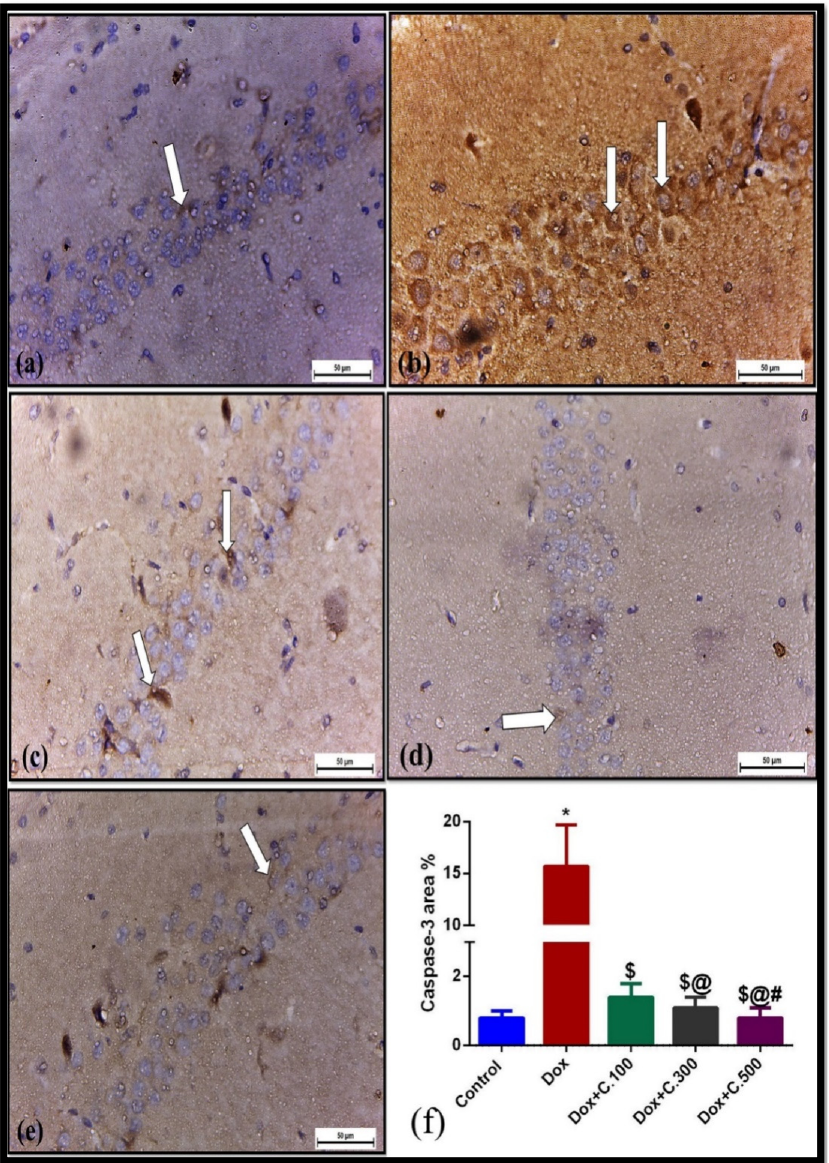
Figure 4. Immunohistochemically caspase-3-stained hippocampus sections ( × 400). ( a ) Control rats (Group I) showing negligible immunoreactivity to caspase-3 (arrow). ( b ) Dox-exposed group (Group II) showing strong immunoexpression to caspase-3 (arrow). ( c ) Mild immunoreactivity to caspase-3 (arrow) in Dox+ C.100 administered rats (Group III). ( d ) Dox+ C.300 (Group IV) and ( e ) Dox+ C.500 (Group V) treated rats showing negligible immune reaction (arrow). ( f ) A bar graph showing a significant increase in the area% covered by Caspase3-positive immunoreactive cells within the hippocampus in Dox-exposed albino rats (Group II) compared to the control rats (Group I) and a significant decrease in Dox+ C. macrocarpa treated rats (Groups III, IV, and V) compared to Dox-exposed rats. Data are presented as mean values ± SEM, one-way ANOVA followed by post hoc test Tukey test for seven rats in each group. * Significant from control group, $ Significant from Dox group, @ Significant from Dox+ C.100 group, and # Significant from Dox+ C.300 group, p <